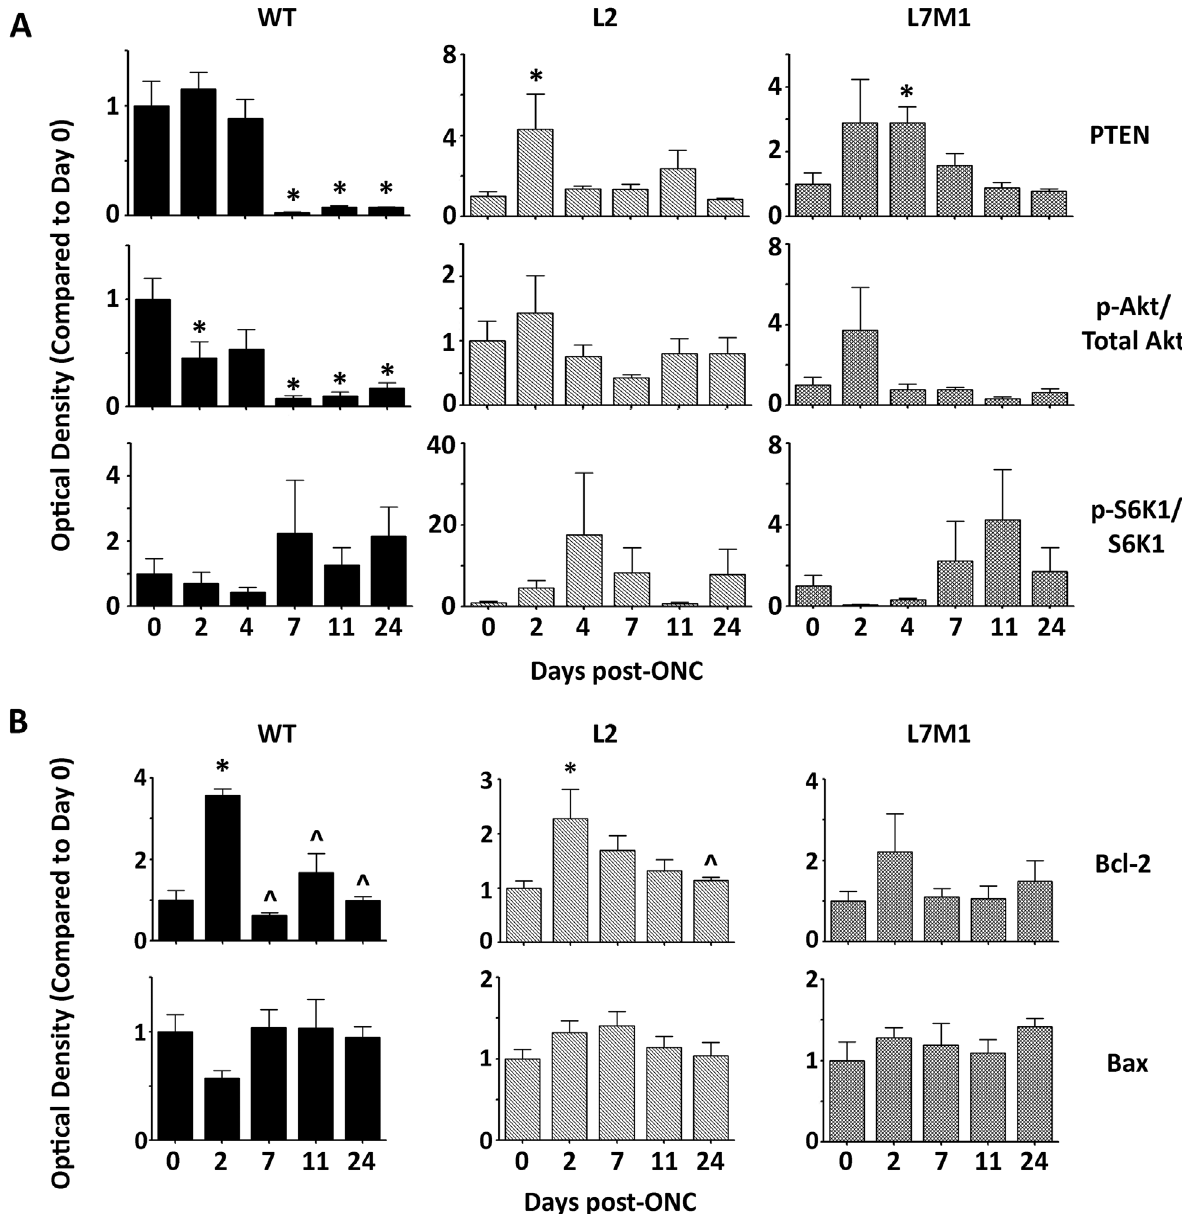
Fig 6. Immunoproteasome Deficiency Alters Content of Stress Proteins after ONC. ( A and B ) Protein was isolated from WT, L2, or L7M1 retinas at the indicated time points after ONC. Results are the optical density of PTEN, p-Akt/Akt, and p-S6K1/S6K1 ( A ), or Bcl-2 and Bax ( B ) protein content. Data is shown relative to each mouse strains ’ control (day 0) and represent the mean ± S.E. of 3 – 9 mice/group. ( * , p (cid:1) 0.05 by one-way ANOVA with Dunnett ’ s post- test compared to the ‘ day 0 ’ values or (^, p (cid:1) 0.05 by one-way ANOVA with Dunnett ’ s post-test compared to the ‘ day 2 ’